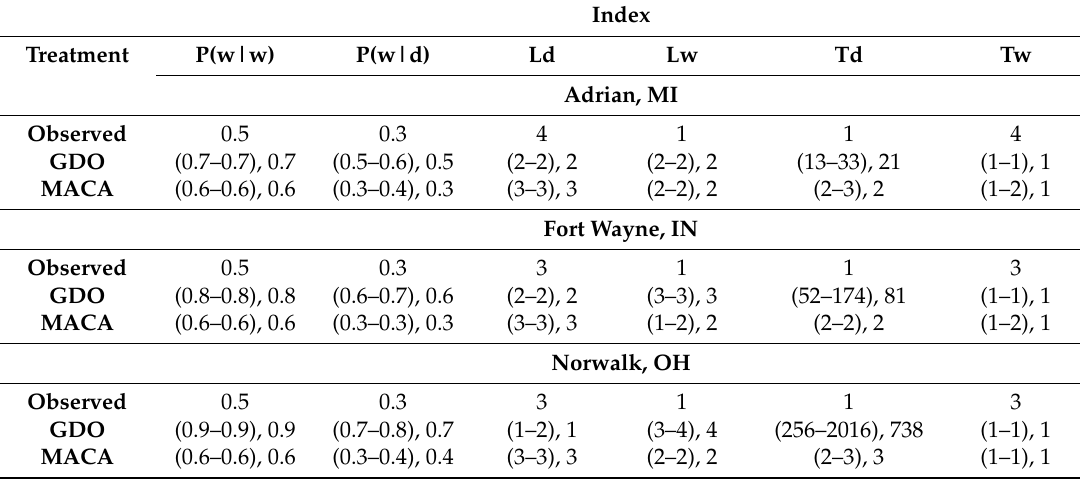
Figure 4. Comparison of GDO and MACA climate projection sources while simulating different climate indices for Adrian, MI between 1966 and 2005 (GDO_NT: GDO No Treatment; MACA_NT: MACA No Treatment). Plots for Fort Wayne, IN and Norwalk, OH can be seen in Figure S3A,B. Table 4. Comparison of GDO and MACA climate projection sources for different climate indices for Adrian, MI, Fort Wayne, IN, and Norwalk, OH for 1966 to